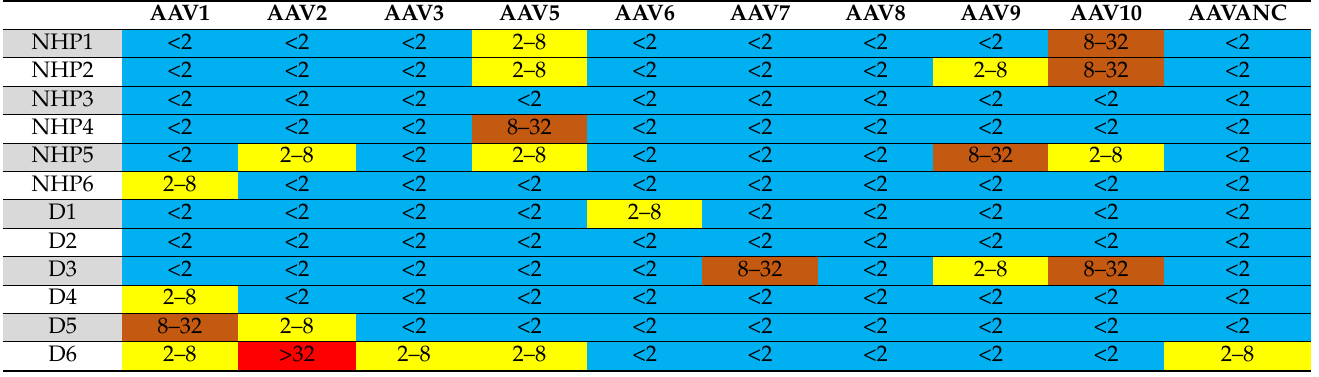
Table 2. Summary of AAV NAB profiles for each individual animal subject. Blue, yellow, brown, and red correspond to AAV NAB titers ≤ 2, 2–8, 8–32, and ≥ 32,